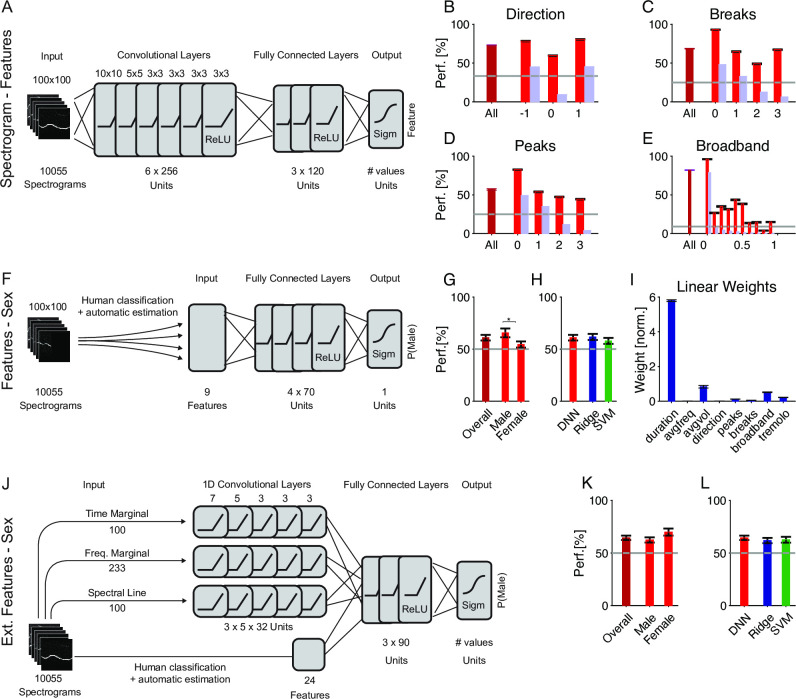
Features alone are insufficient to explain the DNN classification performance.A Features of individual vocalizations can also be measured using dedicated convolutional DNNs, one per feature, with identical architecture as for sex classification (see Fig 3A). B-E Classification performance for different properties was robust, ranging between 57.0 and 82.0% on average (maroon) and depending on the individual value of each property (red). We trained networks for direction ({-1,0,1}, B), the number of breaks ({0–3}, C), the number of peaks ({0–3}, D) and the degree of broadband activation ([0,1], E). For the other 2 properties (complex and tremolo), most values were close to 0 and thus networks did not have sufficient training data for these. The light gray lines indicate chance performance, which depends on the number of choices for each property. The light blue bars indicate the distributions of values, also in %. F Using a non-convolutional DNN, we investigated how predictable features alone would be, i.e. without any information about the precise spectral structure of each vocalization. G Prediction performance was above chance (maroon, 59.6±3.0%) but less than the prediction of sex on the basis of the raw spectrograms (see Fig 3). The gray line indicates chance performance. H Feature-based prediction of sex with DNNs performed similarly compared to ridge regresson (blue) and SVM (red, see main text for statistics). I Duration, volume and the level of broadband activation were the most significant linear predictors for sex, when using ridge regression. J Using a semi-convolutional DNN, we investigated the combined predictability of the same features as above, plus 3 statistics of the stimulus (each a vector), i.e. the marginal of the spectrogram in time and frequency, as well as the spectral line, i.e. the sequence of frequencies of maximal amplitude per time-bin. K The average performance of the semi-convolutional DNN (64.5%) stays substantially lower than the 2D cDNN (see Fig 3D). USVs of both sexes were predicted with similar accuracy. L The average performance of the semi-convolutional DNN is not significantly larger than ridge regression (61.9%) or SVM (62.7%) on the same data, due to the large variability across the sexes (see Panel K).